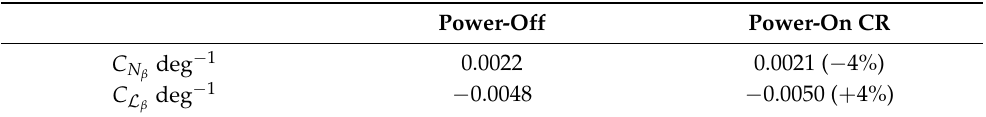
Table 12. Indirect propulsive effects on directional and lateral stability derivatives,